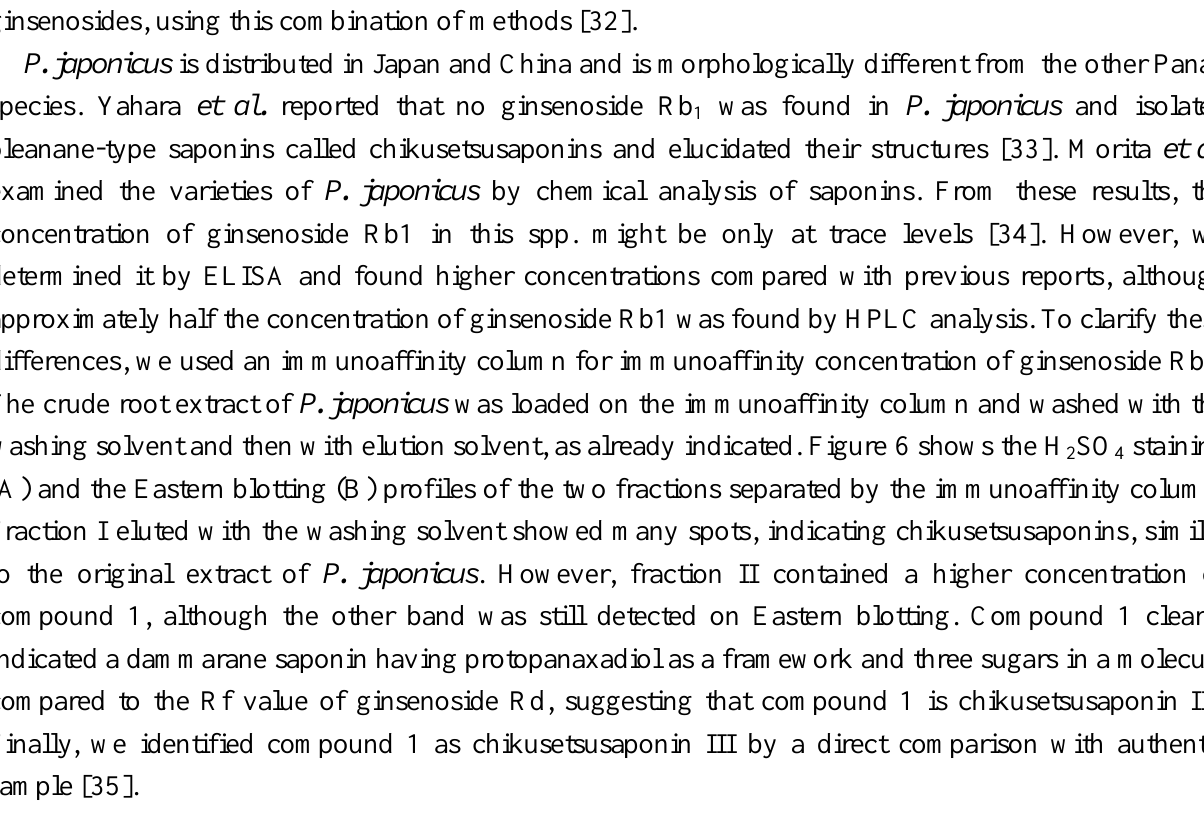
Figure 6. Purification and determination of ginsenosides of P. japonicus by immune- affinity column and Eastern